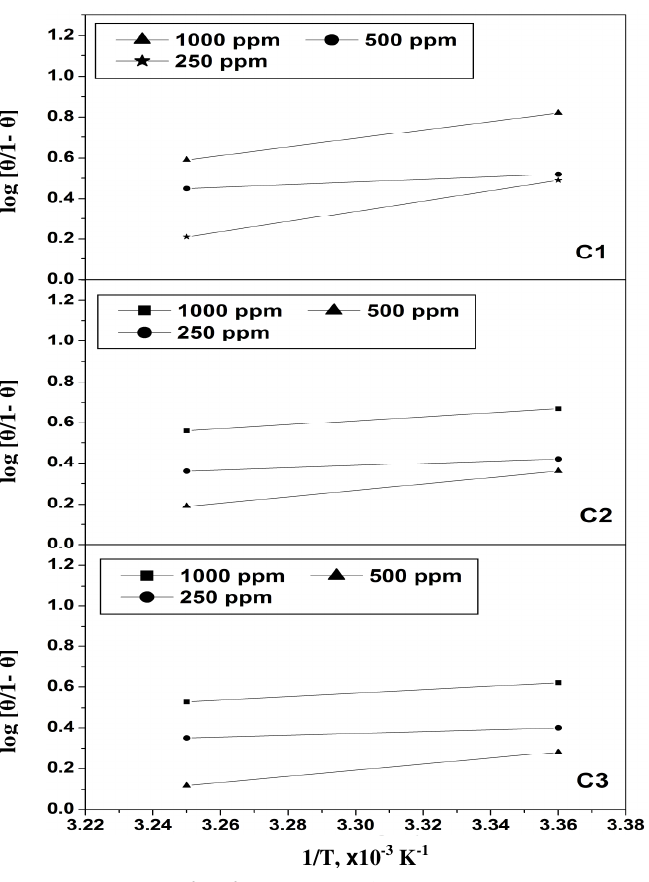
Figure 5. Arrehenius plots log ( θ / 1- θ ) vs. 1/T in 0.5 N HCl at various concentrations of inhibitors. Table 3. Electrochemical, thermodynamic parameters and inhibition efficiency obtained for mild steel in 0.5 N HCl with different concentrations of inhibitors at 298